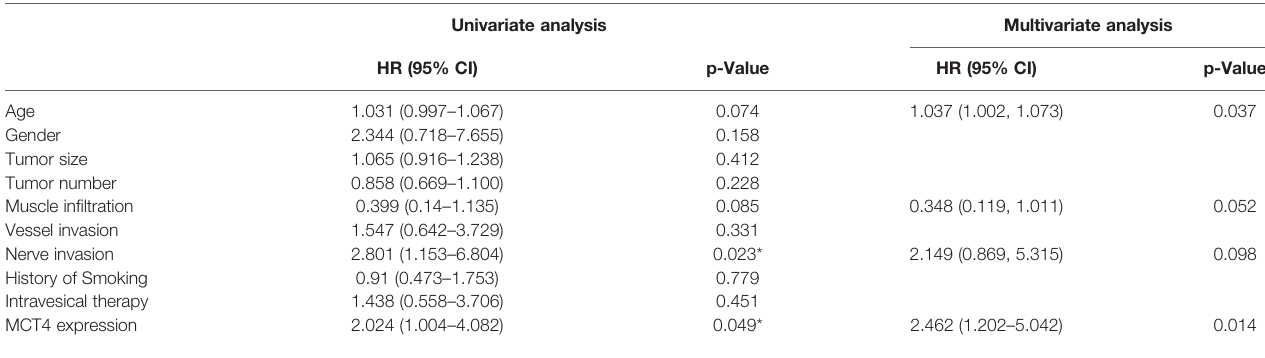
TABLE 3 | Univariate and multivariate Cox